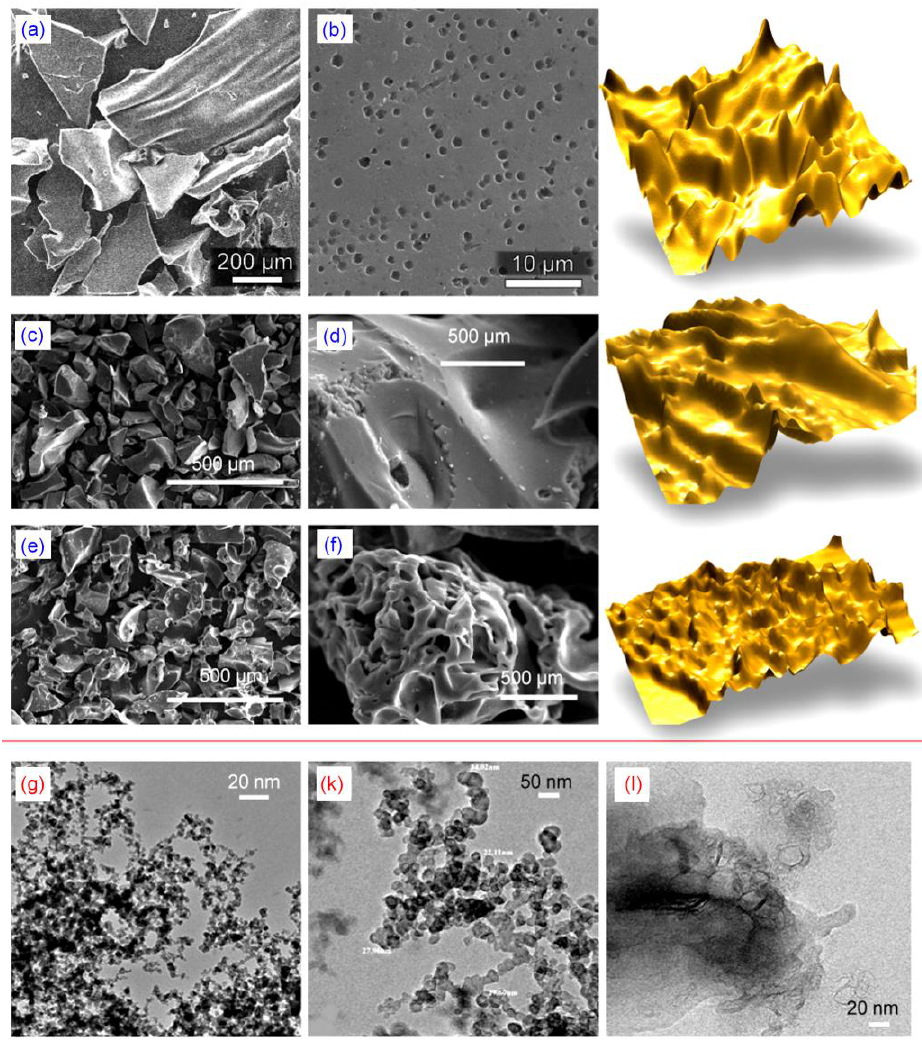
Figure 2. Upper panel: SEM images and 3D reconstructions of nitrogen self-doped graphene-based carbon aerogels activated at ( a , b ) 700 °C, ( c , d ) 800 °C, and ( e , f ) 900 °C. Lower panel ( g , k , I ): TEM images of the 3D nitrogen self-doped graphene-based carbon aerogel activated at 800 °C. The 3D reconstructions were made by translating the grayscale images into 3D using the Gwyddion © visualization and analysis free software (released by GPL license), to illustrate the morphology only, with arbitrary height.